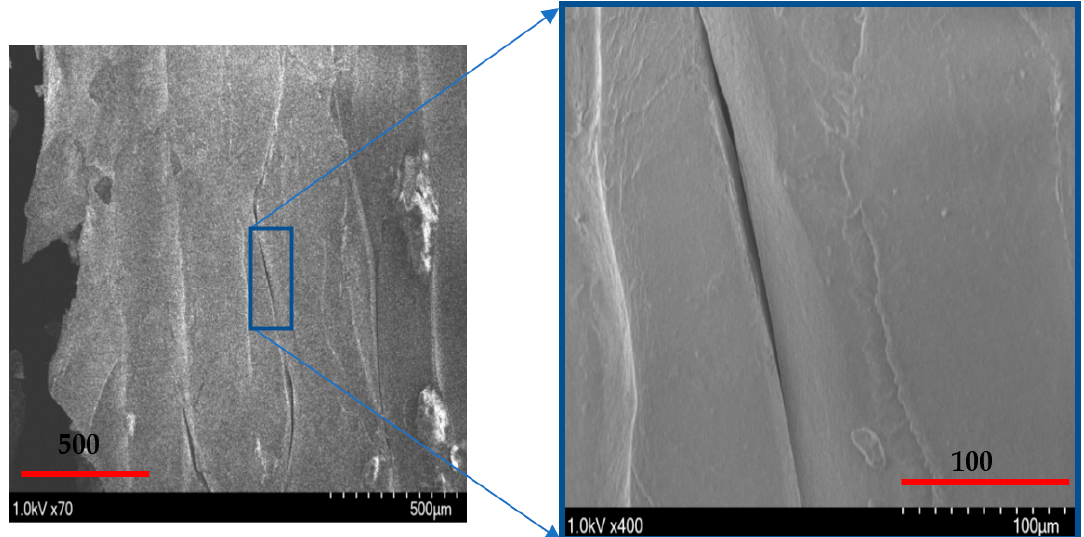
Figure 8. Scanning electron microscope image of the shear zone in the Vertical orientation with a 0° shear angle.